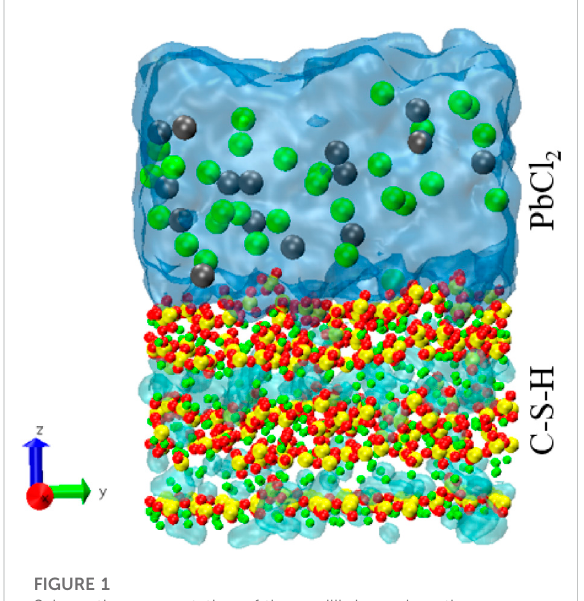
FIGURE 2 XRD pattern of MSWI fl y ash.